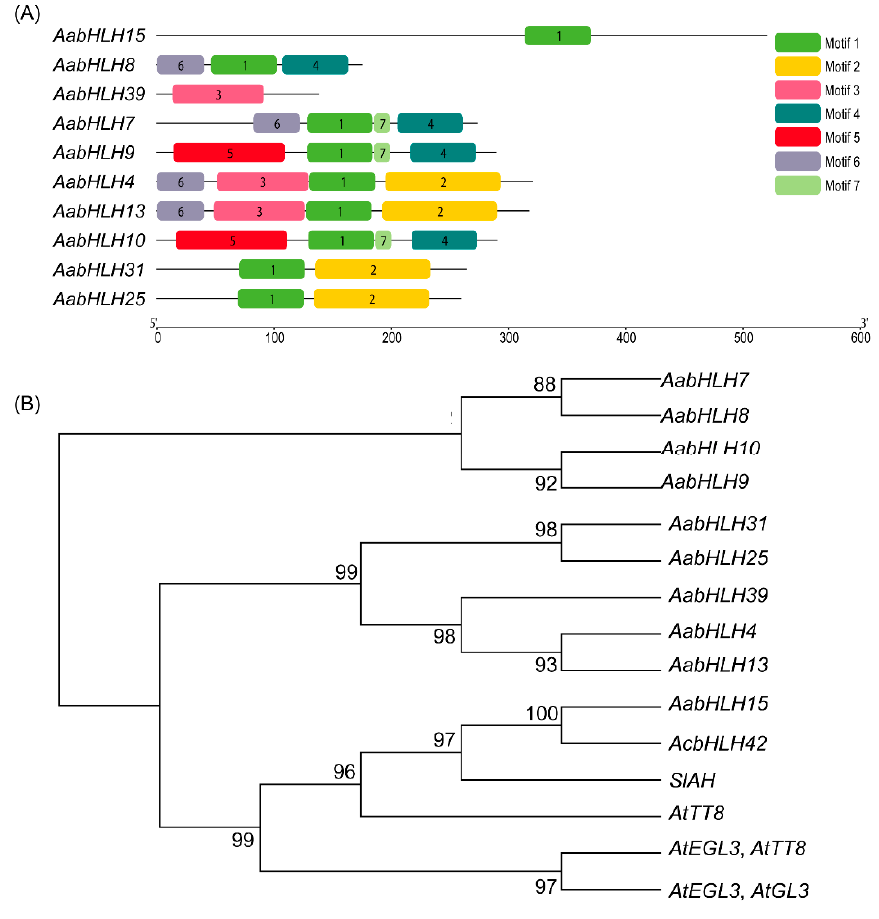
Figure 6. ( A ) The amino acid motifs of AabHLH family genes in A. arguta cv. Qinziyu. The motifs, numbers 1–6, are displayed in different colored boxes. ( B ) The phylogenetic tree was constructed among anthocyanin biosynthesis-related bHLHs.